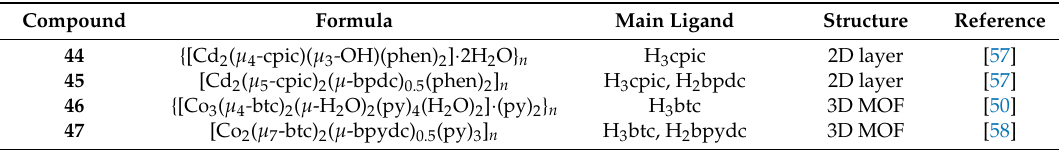
Table 7. Selected examples of CPs showing an effect of two main carboxylate ligands on product structure.